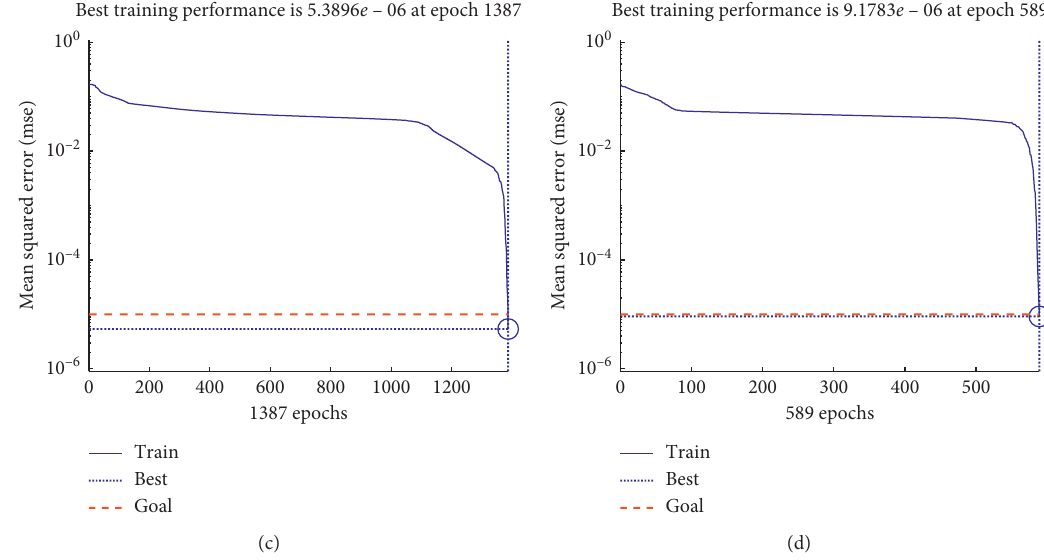
Figure 9: Error convergence curves of four different neural networks. (a) BP neural network error curve. (b) PSO-BP neural network error